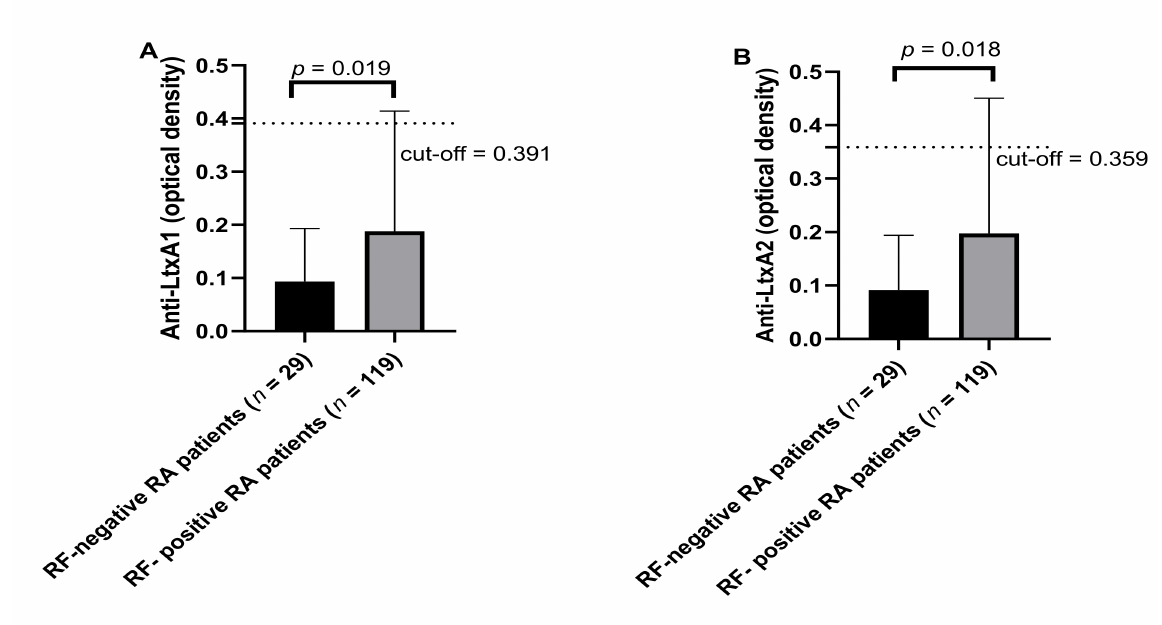
Figure 3. Abs response against LtxA1 ( A ) and LtxA2 ( B ) in RF-positive RA patients vs. RF-negative RA patients. The black bars represent the average ± S, dashed lines represent thresholds used to assess the samples’